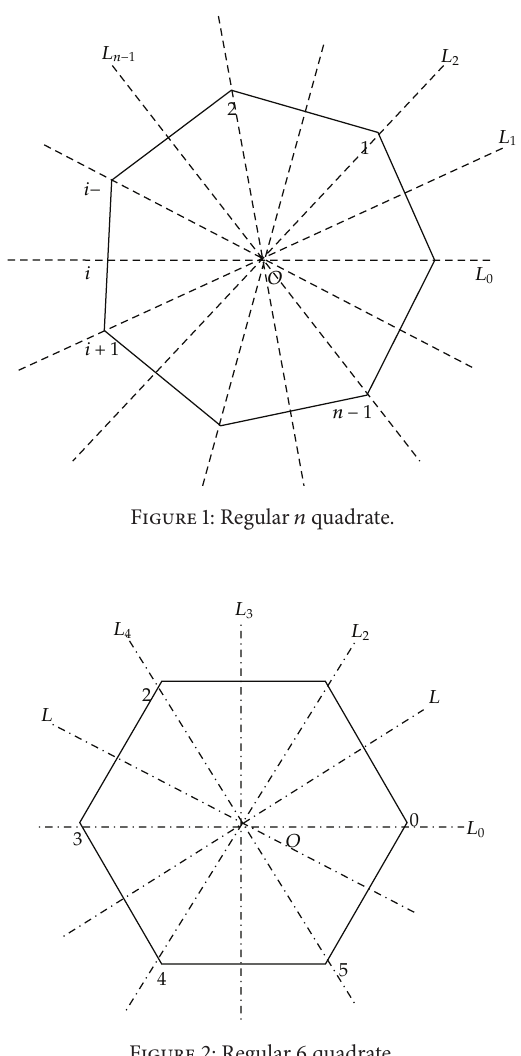
Figure 2: Regular 6